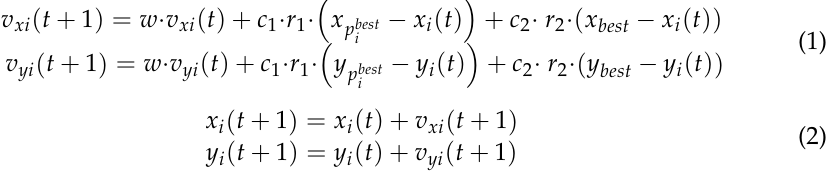
Figure 3. Example of the perpendicular bisector rule.